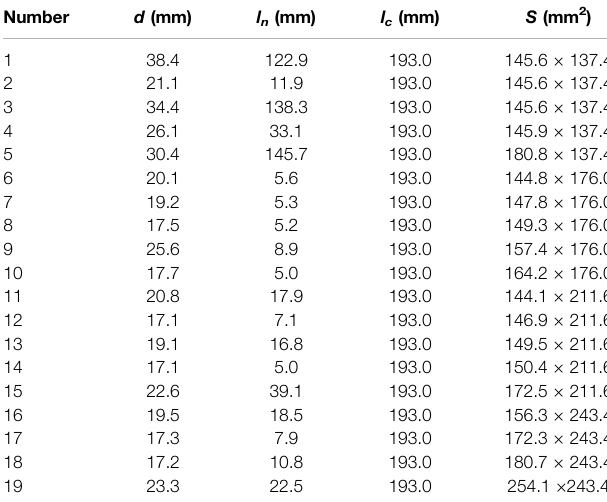
TABLE 5 | Geometric parameters of an optimized metasurface absorber composedof19differentunitcells.Thelateralsizeofthesupercellis78.84 cm × 78.84 cm. The overall thickness of the absorber is 20 cm. Its volume porosity is 90%.